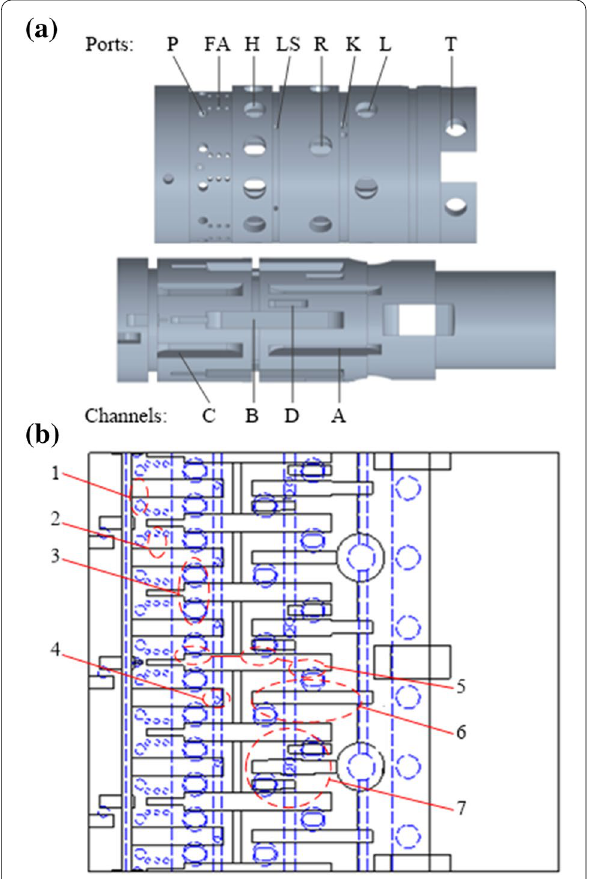
Figure 2 Structure of the rotary valve: a solid model of control spool and sleeve and b expanded view of control spool and sleeve—(1) inlet module, (2) flow rate amplification module, (3) metering motor module, (4) load sensor module, (5) working module, (6) return module, and (7) bypass